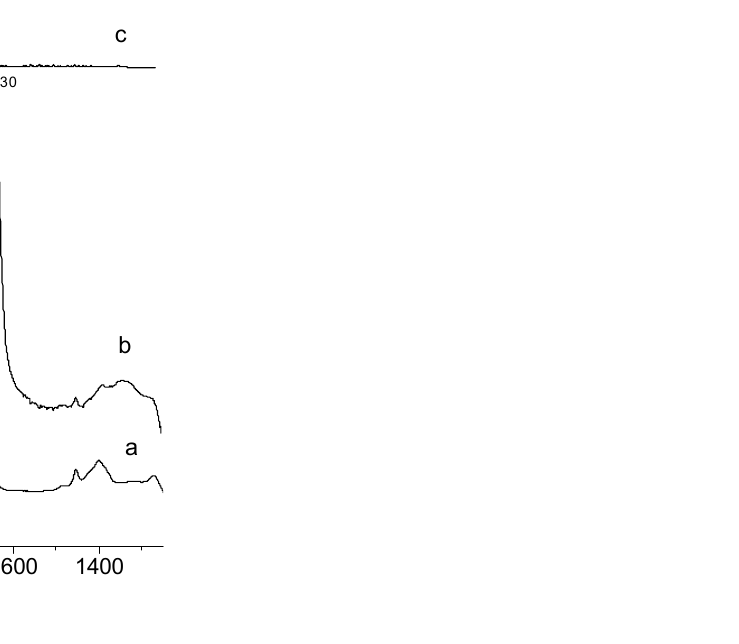
Figure 6. The IR spectra of the products of the reaction of the 1st (a) and 8th dose (b) of ethanol on CeO 2 , as well as the products of the oxidation of ethoxyl groups (c). These products were adsorbed on zeolite NaY.